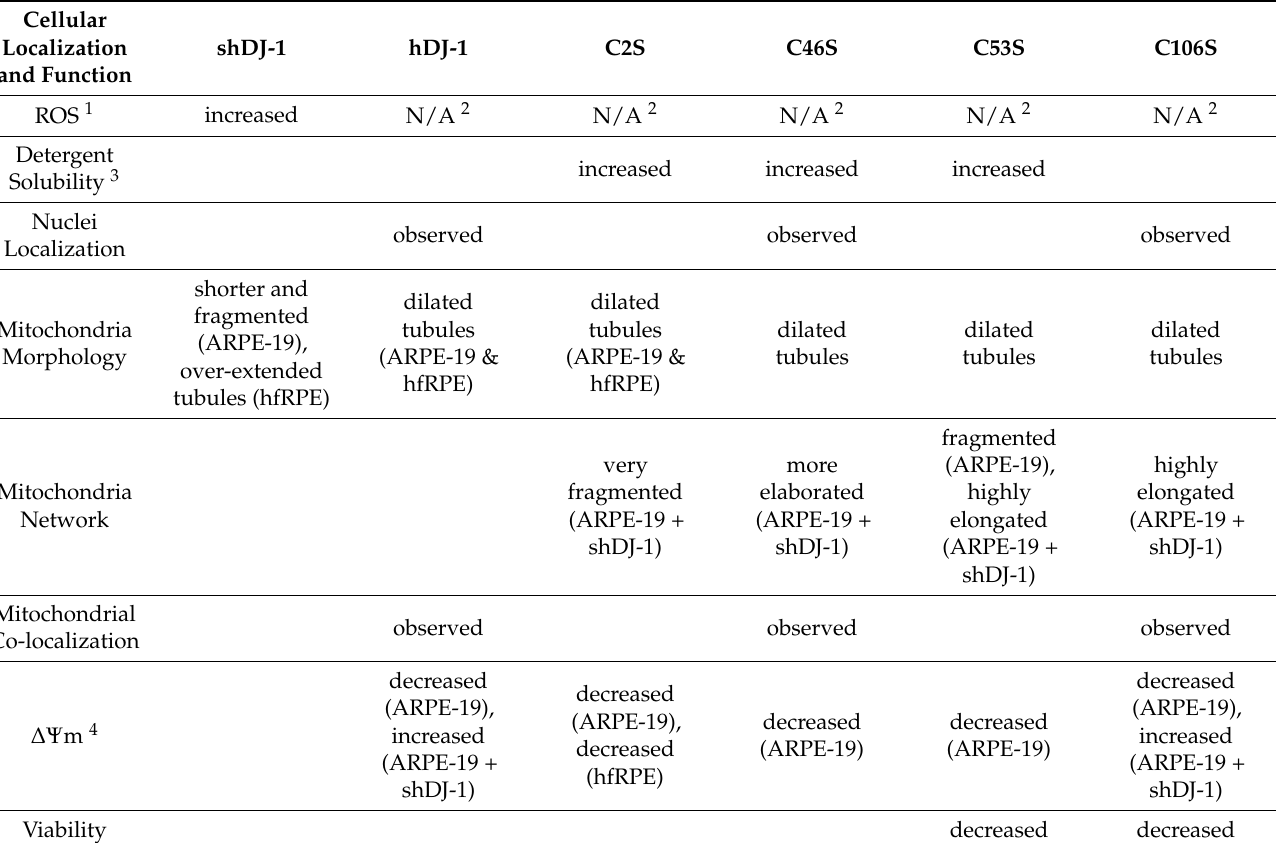
Table 1. Summary of impact of DJ-1 expression changes and oxidation of its C residues on RPE